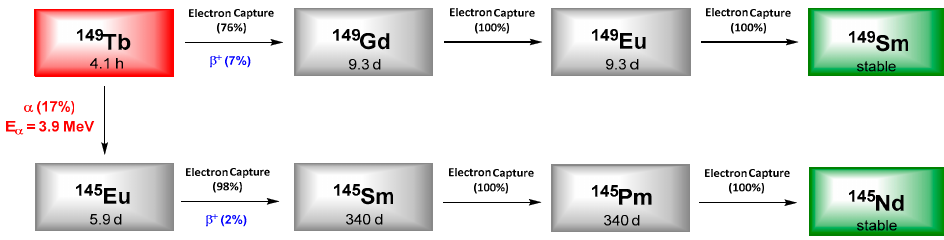
Figure 9. Decay scheme of 149 Tb.